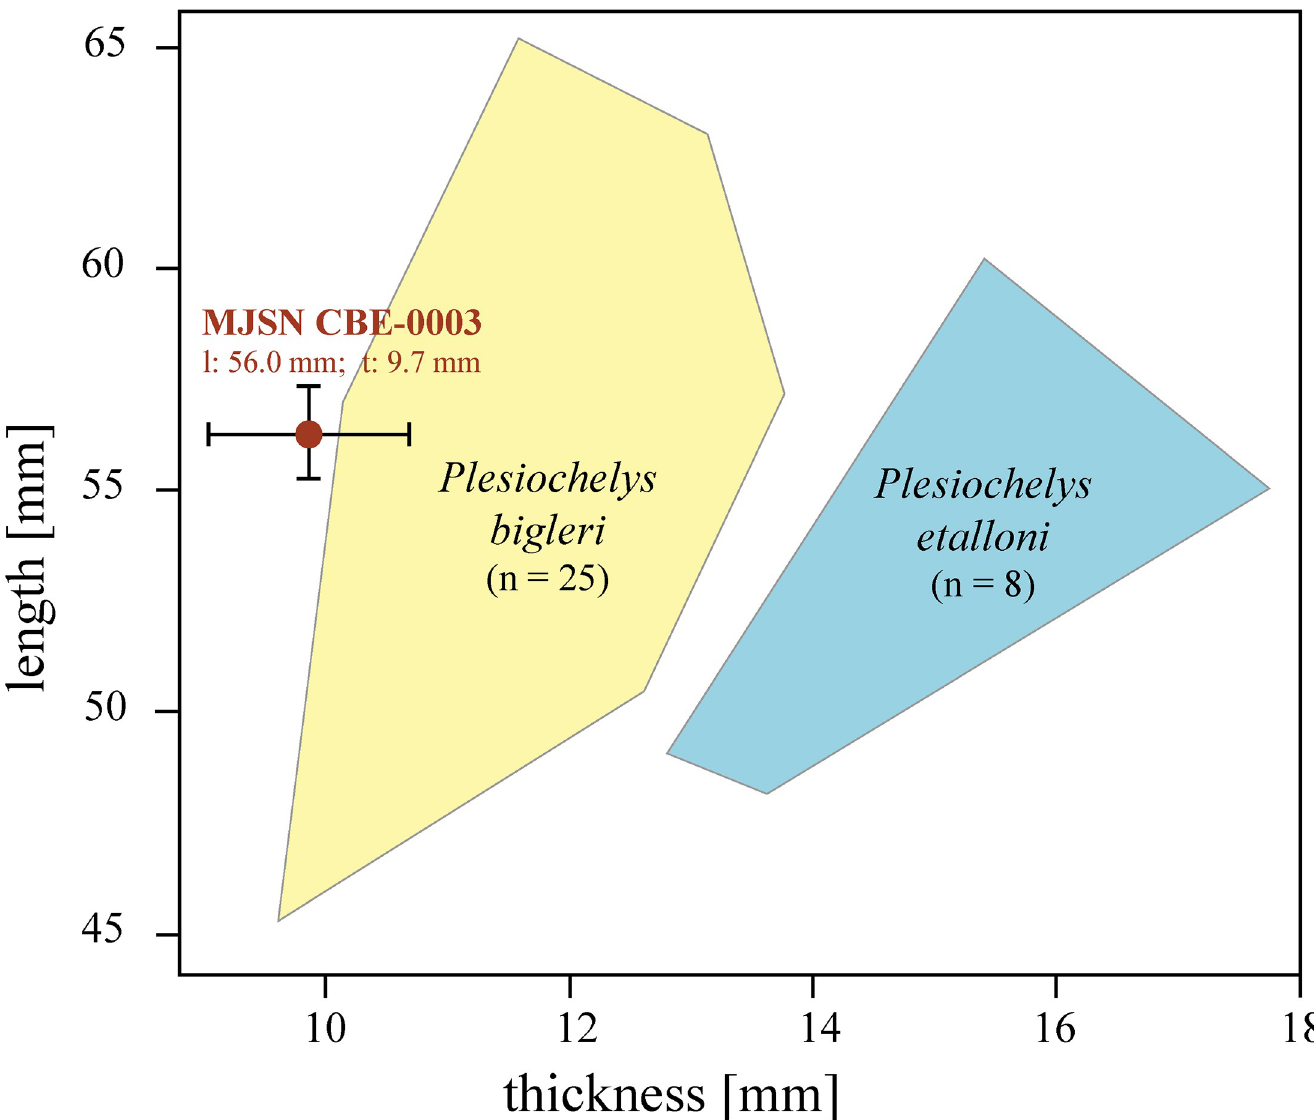
Fig 7. Mean neural length/thickness scatter plot for MJSN CBE-0002 (brown) and selected specimens of Plesiochelys bigleri (yellow) and Plesiochelys etalloni (blue). Graph modified after Pu¨ntener et al. [11]. Mean measurements of the new specimen MJSN CBE-0002 are plotted with the estimated range of error, which resulted from measurement limitations (see